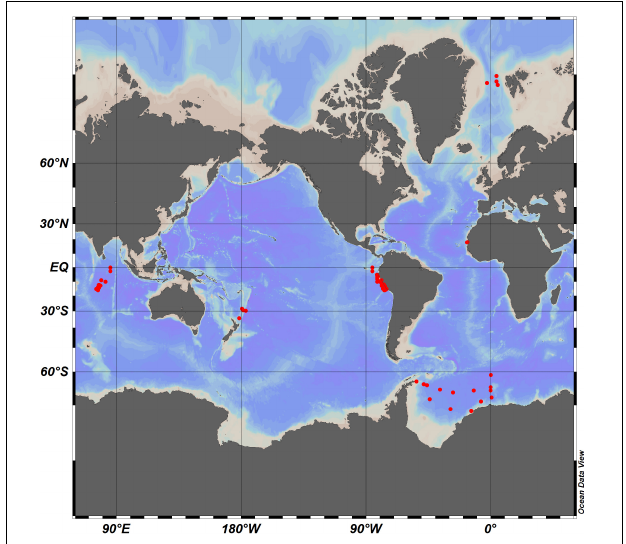
FIGURE 1 | Global map showing the sampling stations at the six different sampling sites.